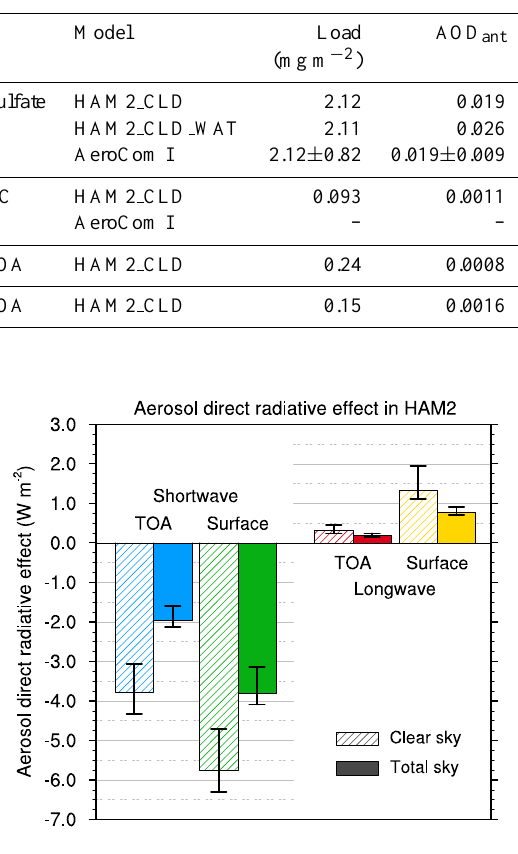
Fig. 22. Global and annual mean aerosol direct radiative effect sim- ulated by HAM2 at top of the atmosphere (TOA) and at the Earth’s surface. Whiskers indicate the spread among the HAM2 sensitivity experiments listed in Table